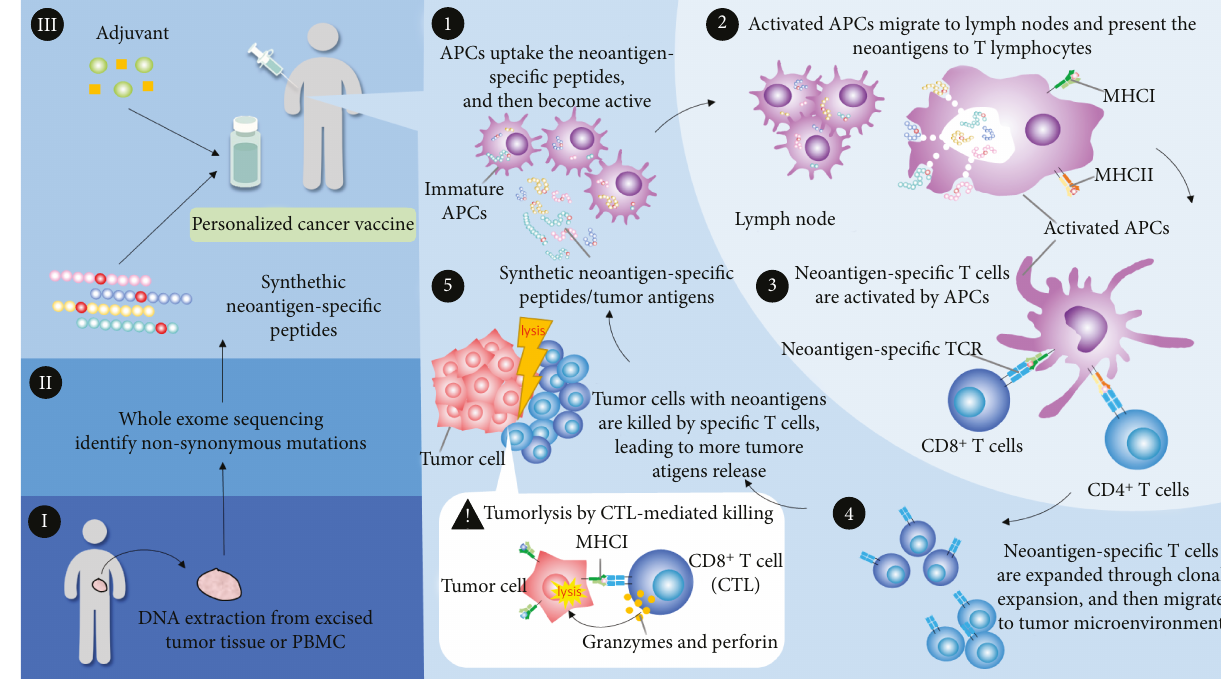
Figure 2: The designing strategies and immunology of personalized neoantigen cancer vaccine. (I – III) The tumor neoantigens of an individual are identi fi ed using the whole exome sequencing, and the personalized neoantigen cancer vaccine is introduced. (1) The APCs uptake the neoantigen peptides in the vaccination sites and then migrate to the lymph nodes. (2) The activated APCs present the neoantigens by MHC class I or MHC class II molecules to T cells. (3) The neoantigen-speci fi c TCR recognizes the speci fi c neoantigen presented by the MHC molecules of APCs. (4) The neoantigen-speci fi c CD4 + helper or CD8 + cytotoxic T cells are activated and clonally expanded and then migrate to the tumor microenvironment. (5) The tumor cells are killed directly by neoantigen-speci fi c CD8 + cytotoxic T cells, leading to the release of more of tumor neoantigens. APC: antigen-presenting cell; MHC: major histocompatibility complex; TCR: T cell